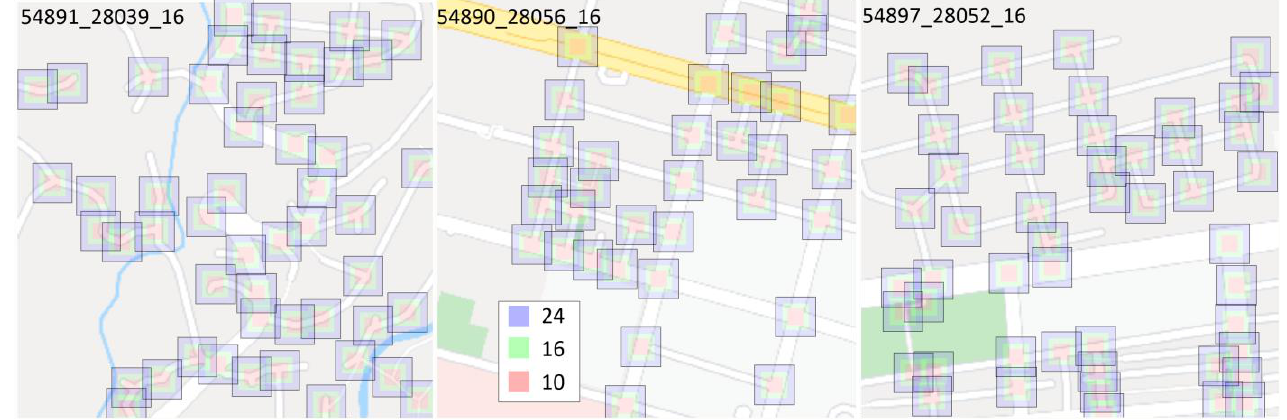
Figure 2. Samples of road networks with proposed three sizes of squares.